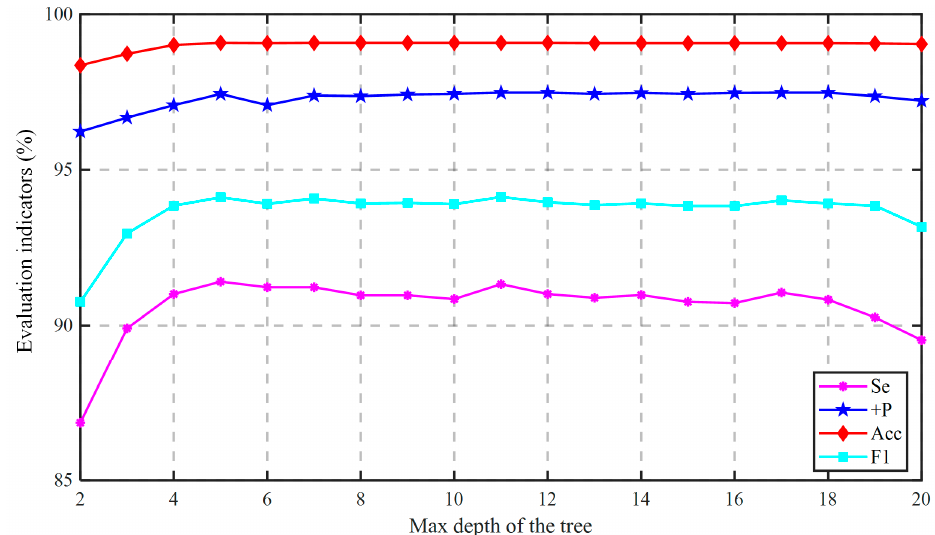
Figure A3. The performance change with the “max_depth”.